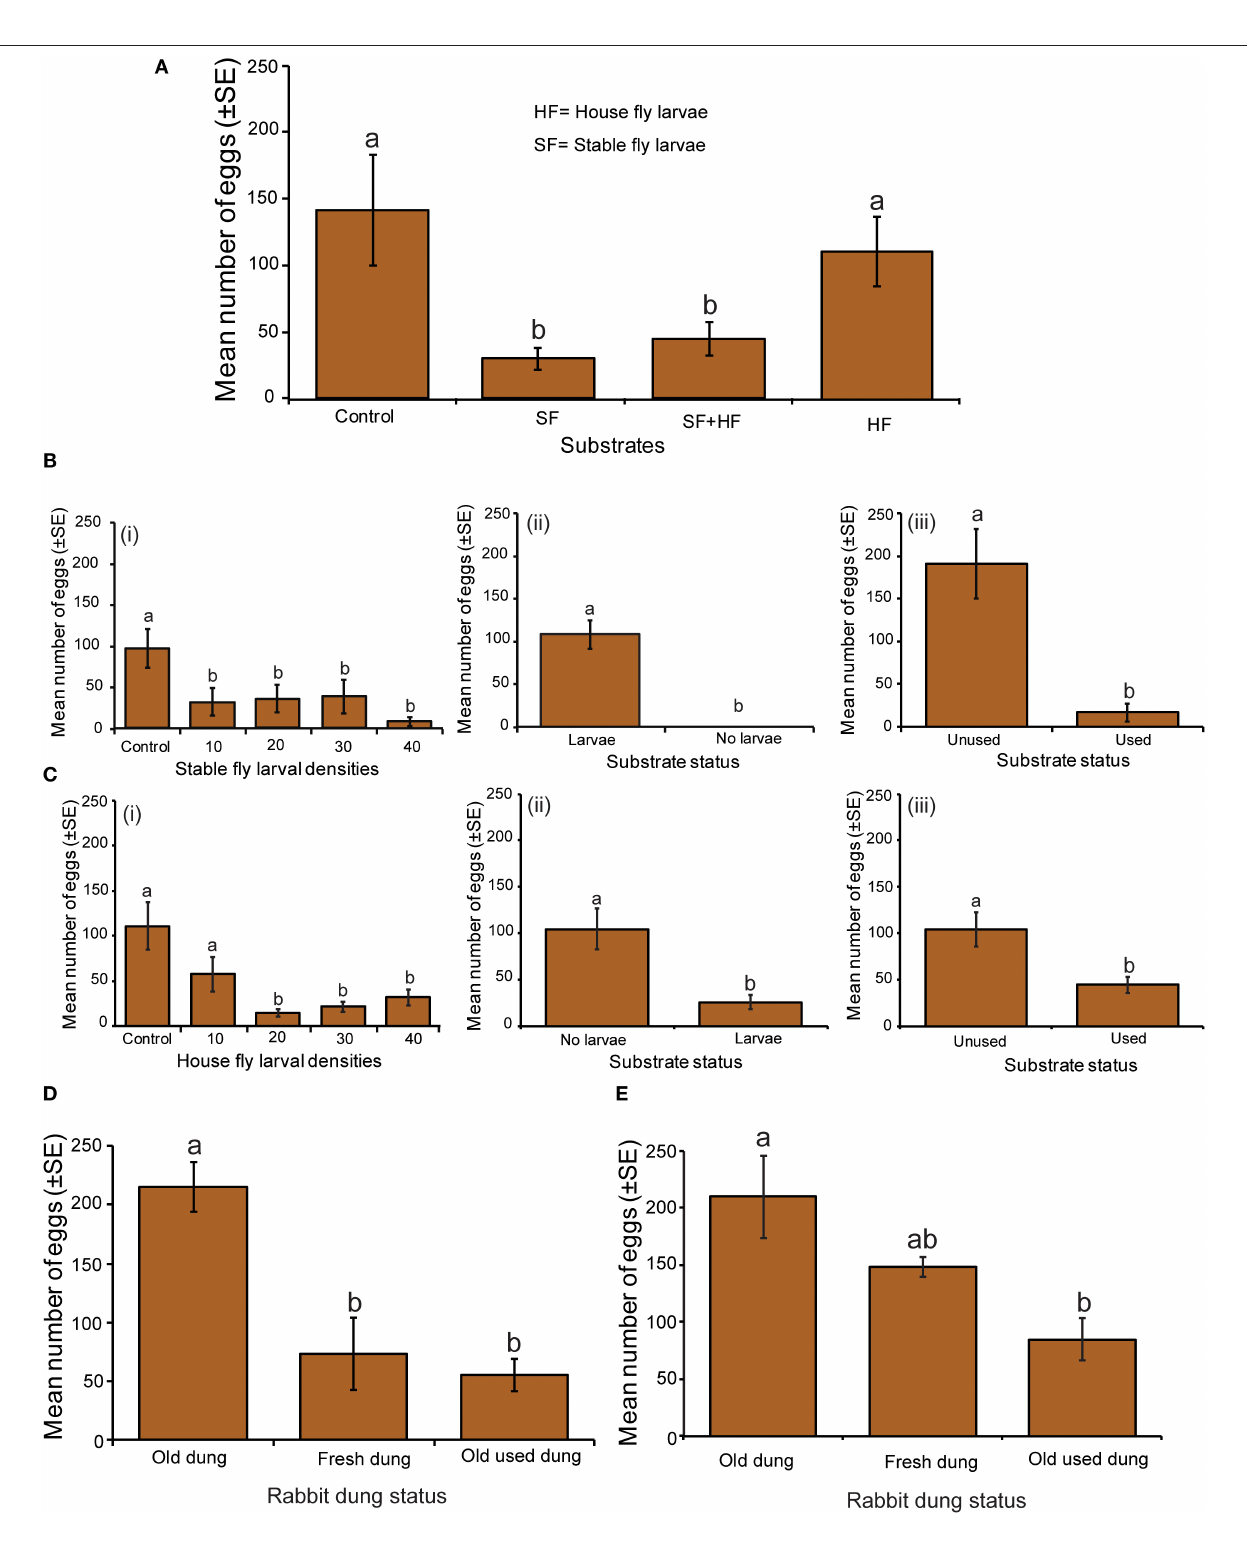
FIGURE 1 | Influence of the presence of S. calcitrans and M. domestica larvae on oviposition decisions by S. calcitrans . (A) Bar chart showing the mean number of eggs laid by gravid female S. calcitrans in the presence of conspecific larvae and the larvae of the house fly (HF), M. domestica . (B) Bar charts illustrating the mean number of eggs laid by gravid female S. calcitrans in the presence of conspecific larvae following three experimental conditions: (i) different larval densities, (ii) in darkness, (iii) with unused and used substrates. (C) Bar charts depicting the mean number of eggs laid by gravid female S. calcitrans in the presence